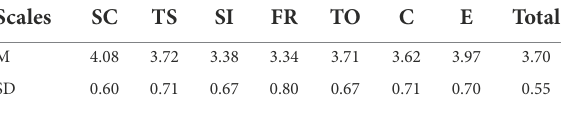
TABLE 3 Descriptive analysis of English classroom